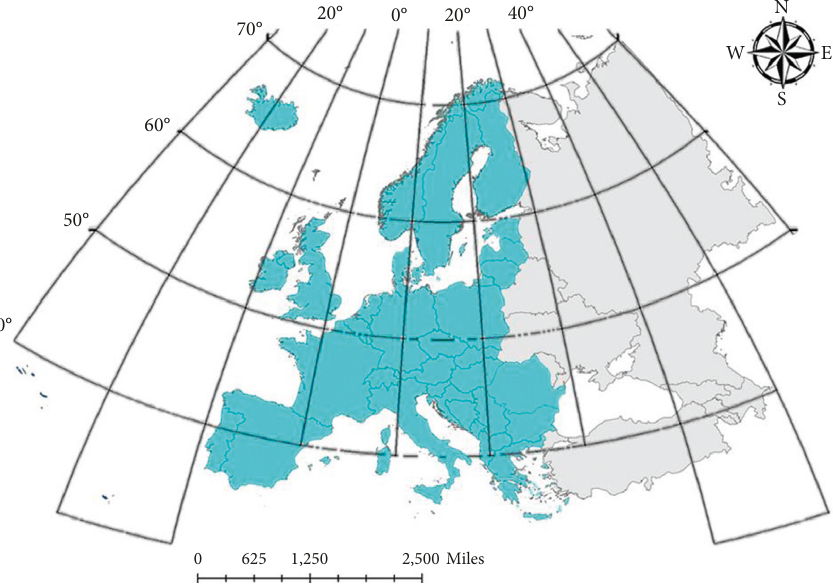
Figure 1: Twenty-five countries in Europe of the study